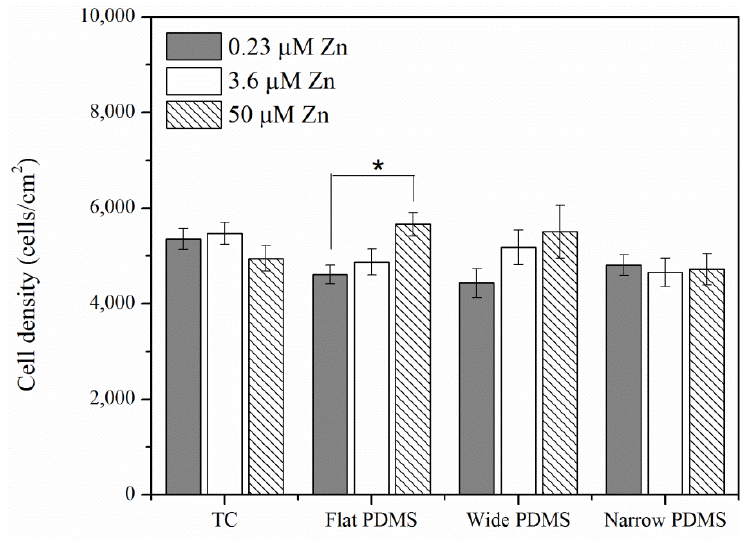
Figure 1. Area density of MC3T3-E1 (subclone 4) pre-osteoblast cells on various substrates with modifications of zinc concentrations after incubation for 24 h. A single asterisk ( * ) indicates a p < 0.01 level of